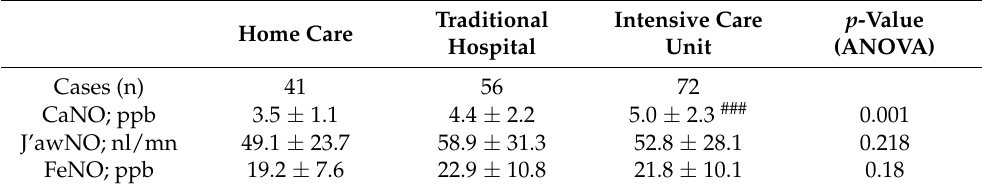
Table 4. Correlations between the clinical severity of the acute COVID-19 (as reflected by the care structure during the acute period and exhaled nitric oxide in patients with recovered SARS-CoV-2 pneumonia.